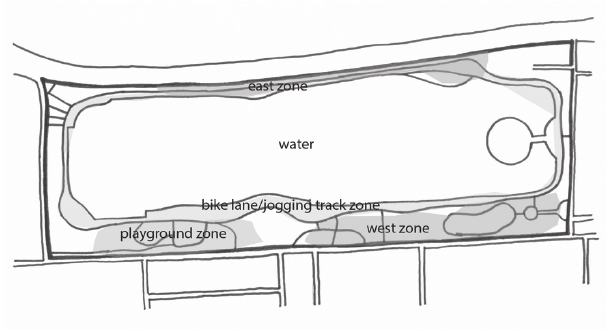
Figure 2. Th e SOPARC observation